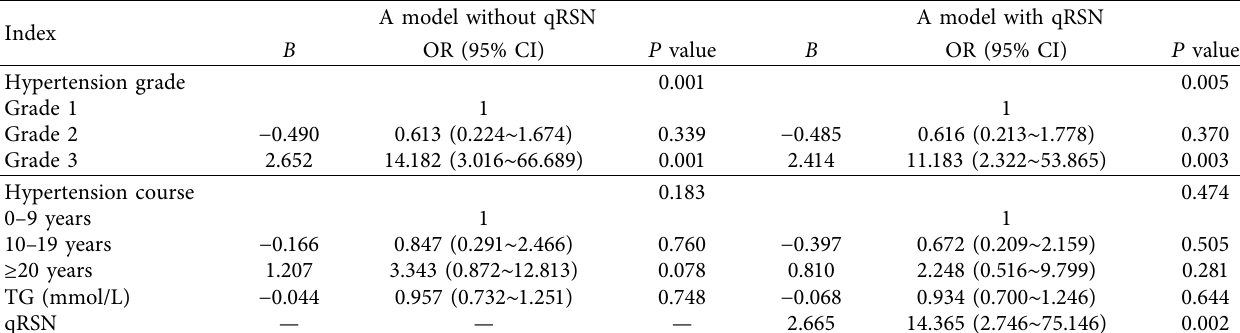
Figure 5: Scatter plots of quantitative classification of renal surface nodularity (qRSN) among patients of different ages. qRSN did not correlate significantly with age in either the control ( r � 0.012, P � 0 . 917) group or the early renal injury group ( r � 0.215, P � 0 . 098). Table 2: Multiple logistic analysis of early renal injury inpatients with arterial